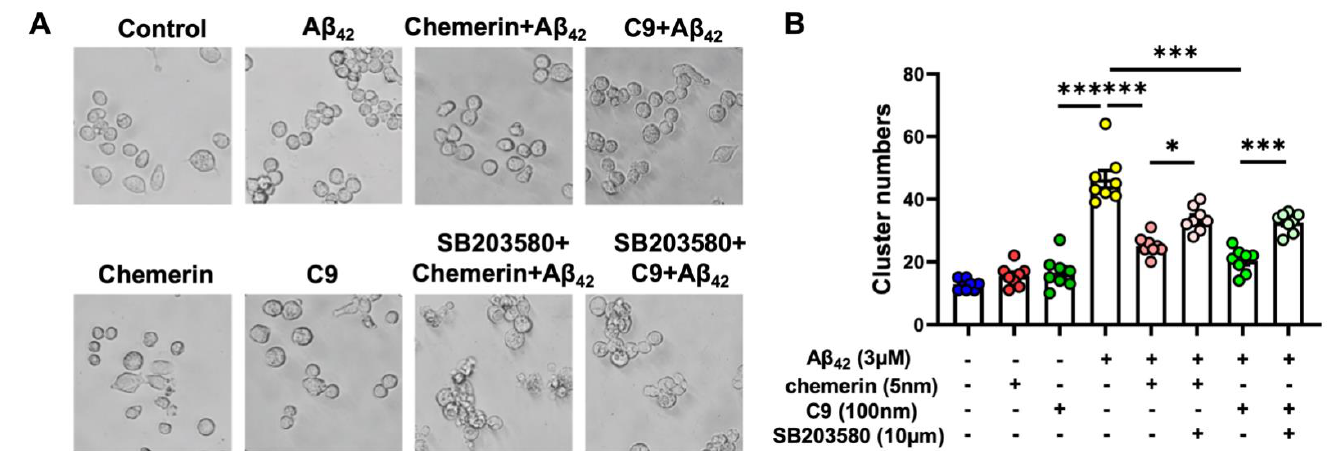
Figure 6. Activation of Chemerin/CMKLR1 axis attenuated Aβ -induced microglial aggregation. ( A ) Microglial N9 cells were incubated with chemerin (5 nM) or C9 (100 nM) for 30 min with or without a 15 min pretreatment with SB203580 (10 μM), followed by 3 μM aggregated Aβ 42 for 24 h. Repre- sentative images of control, Aβ 42 , or Aβ 42 with chemerin or C9 incubation with or without SB203580. Quantification of the number of microglial cells cluster is shown in ( B ). Images were taken from four random fields for each well. The results are expressed as the mean ± SEM from three separate ex- periments, each in duplicate or triplicate. * p < 0.05, *** p < 0.001.